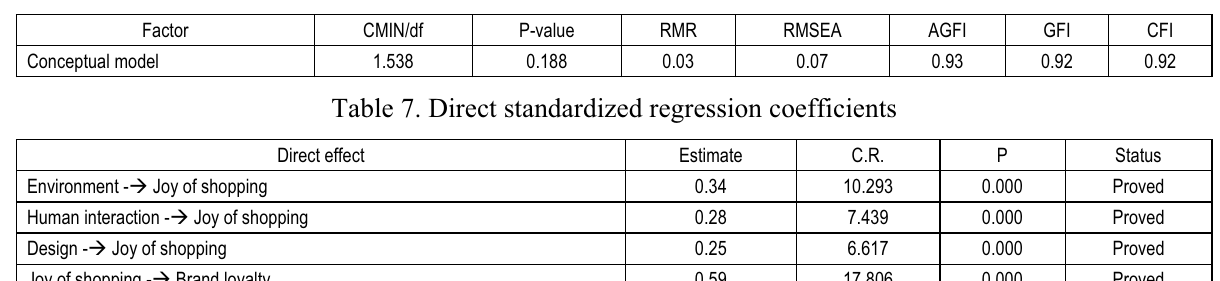
Table 6. Goodness of fit indices for conceptual model